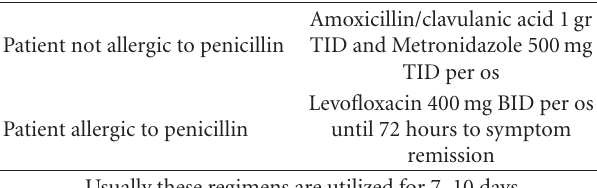
Table 2: Drug therapy for sinus lift complications. Patient not allergic to